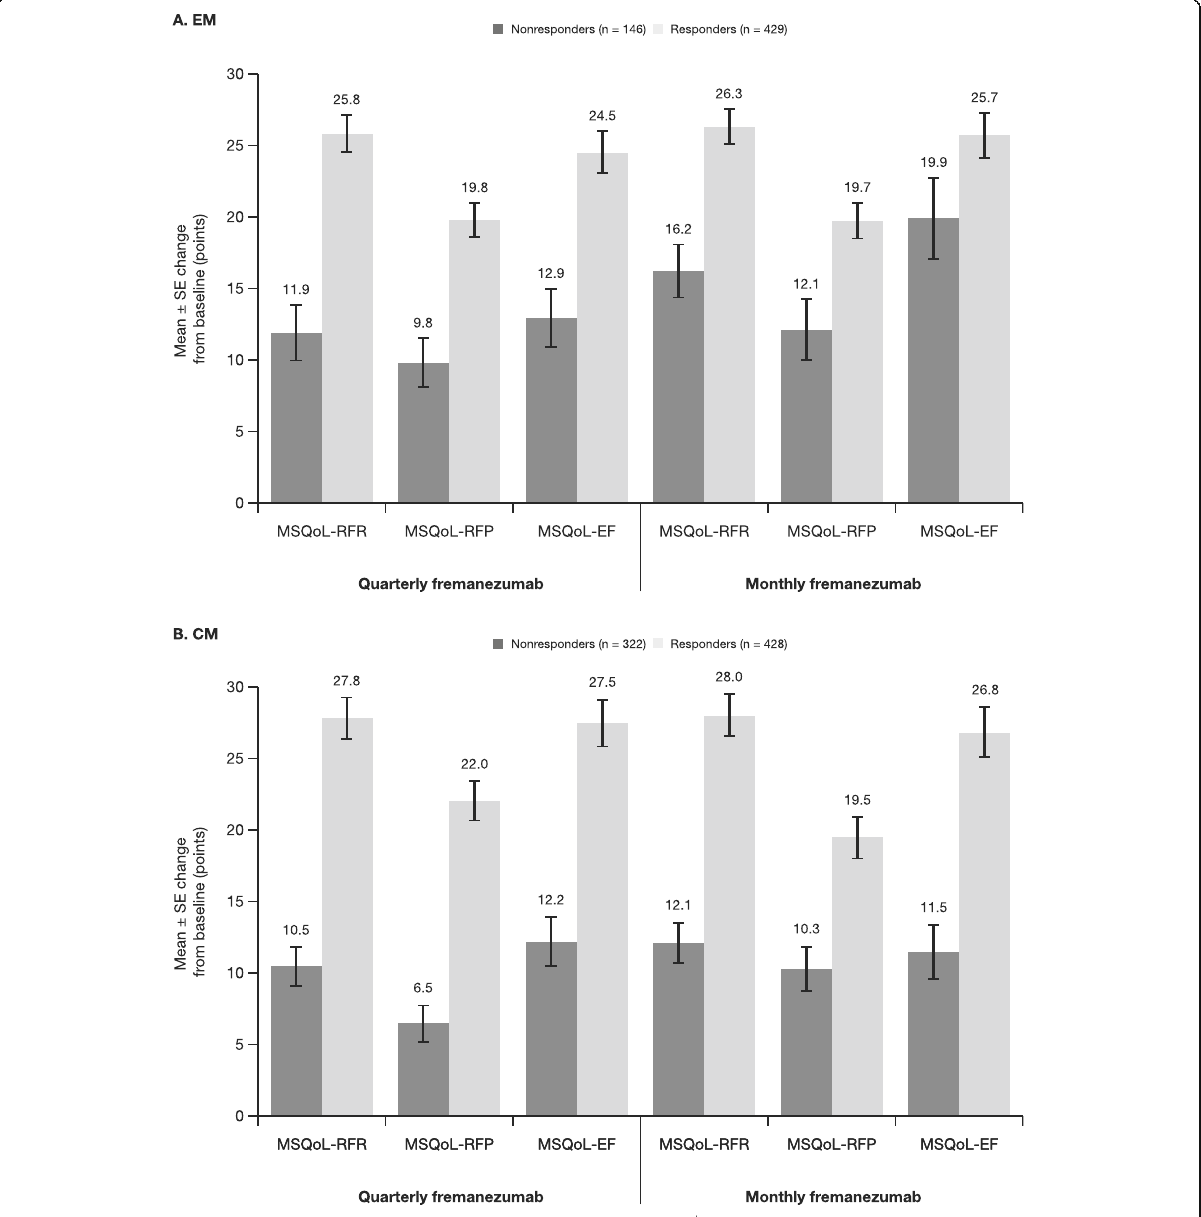
Fig. 6 Mean change from baseline in MSQoL in participants with ( a ) EM a and ( b ) CM b . CM, chronic migraine; EM, episodic migraine; MAMD, monthly average migraine days; MSQoL, Migraine-Specific Quality of Life; MSQoL-EF, MSQoL emotional function; MSQoL-RFR, MSQoL role function – restrictive; MSQoL-RFP, MSQoL role function – preventive; SE, standard error. a For participants with EM, response was defined as a reduction of ≥ 2 MAMD. b For participants with CM, response was defined as a reduction of ≥ 4